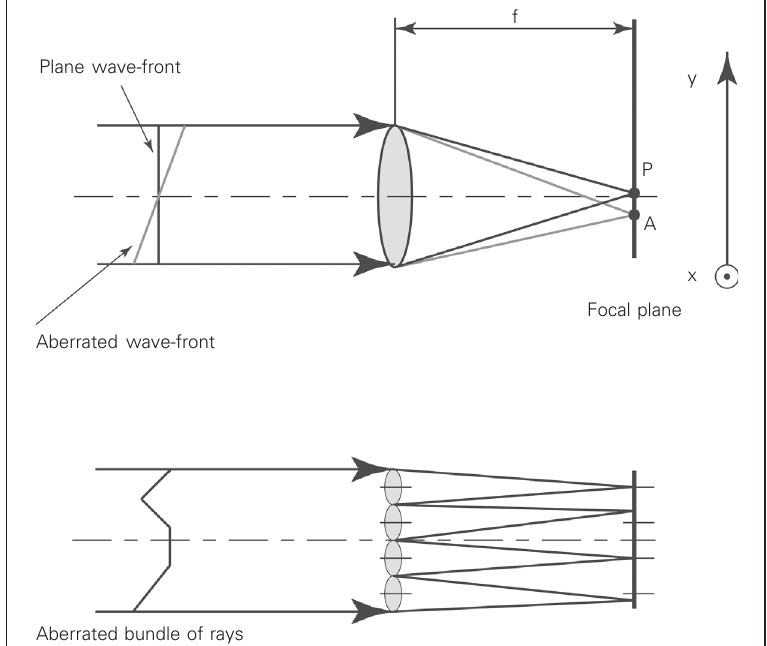
Figure 5. Principle of the Hartmann-Shack (HS) sensor. Upper diagram , A plane wave-front hits a single micro-lens and focuses at a point P located over the optical axis and at a distance f from the lens; for the same micro-lens an aberrated wave-front focuses at point A , also on the focal plane but shifted away from the optical axis. Lower diagram , For a set of micro-lenses, an aberrated wave-front will focus on unevenly spaced points (shifted away from the optical axis of each micro-lens) over the focal plane. It is the quantification of the individual shifts that allows one to determine the local slopes of the wave-front and then, from this information, retrieve the entire wave-front surface. The x,y arrows to the right of the upper diagram show the coordinate system directions ( y is pointing upwards and x is coming outside from the page) used according to Equations 7 and 8.